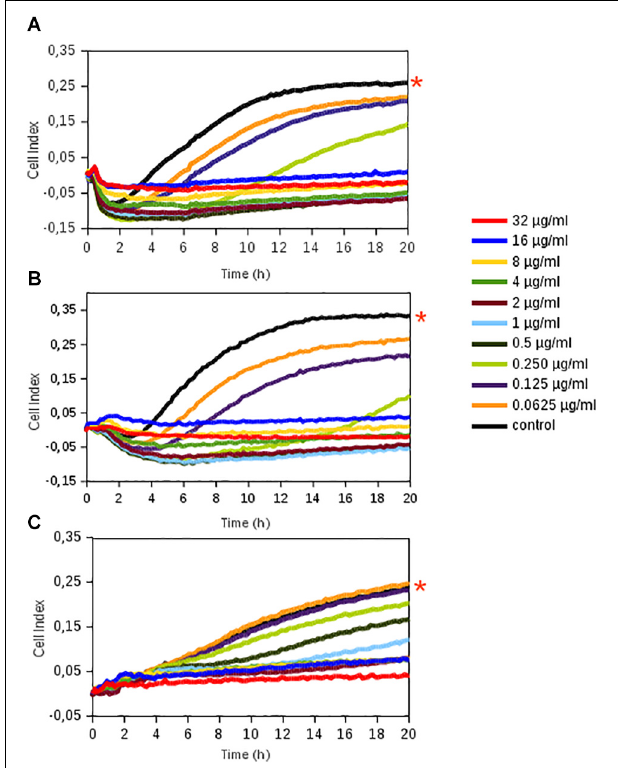
FIGURE 1 | Dalbavancin effect on bacterial biofilm formation in Staphylococcus aureus 240 (A) , S. aureus MRSA 4 (B) , and Staphylococcus epidermidis 43040 (C) strains. The cell index (CI) values are measured by impedance in an xCELLigence equipment and correlate with total biofilm mass. Red asterisks indicate dalbavancin-free controls. Dalbavancin was added from the beginning of the experiment at concentrations from 0.0625 to 32 mg/L as indicated in the legend. Data are the means of two